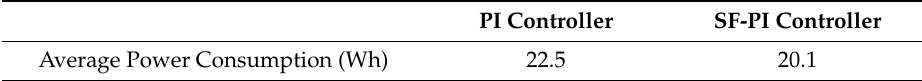
Figure 16. Consumption power comparison in steady-state. ( a ) PI Controller. ( b ) SF-PI Controller. Table 9. Average consumption power comparison in steady-state.